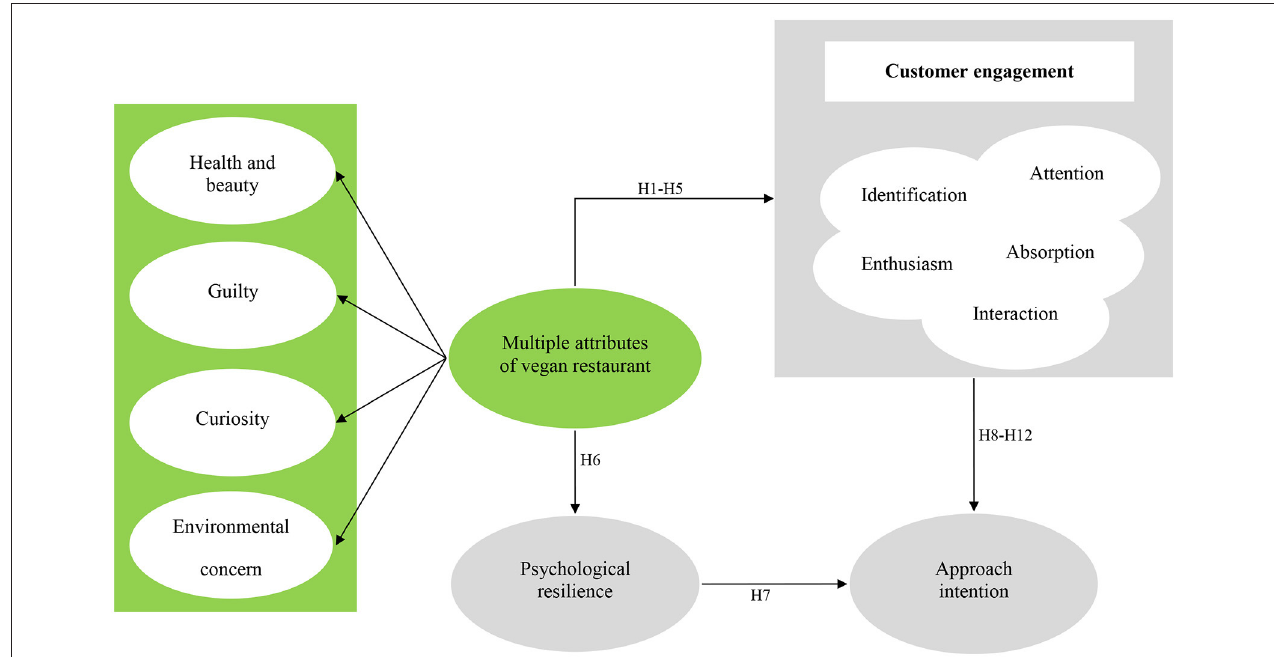
FIGURE 1 | The proposed conceptual